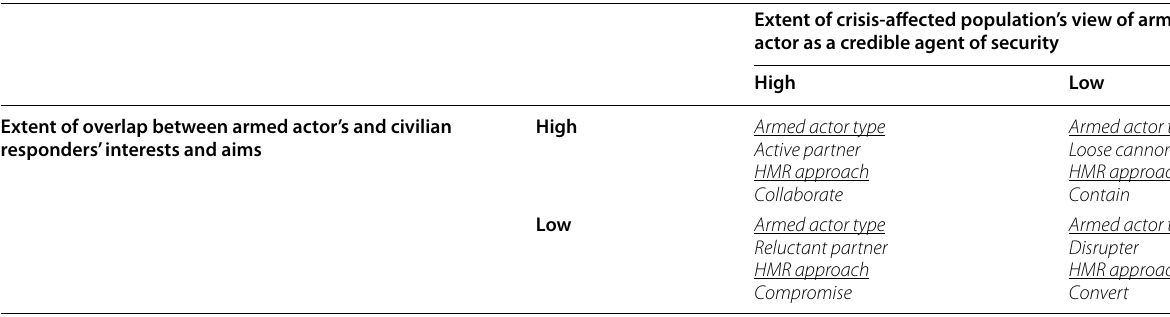
Table 2 A new typology for humanitarian-military relations